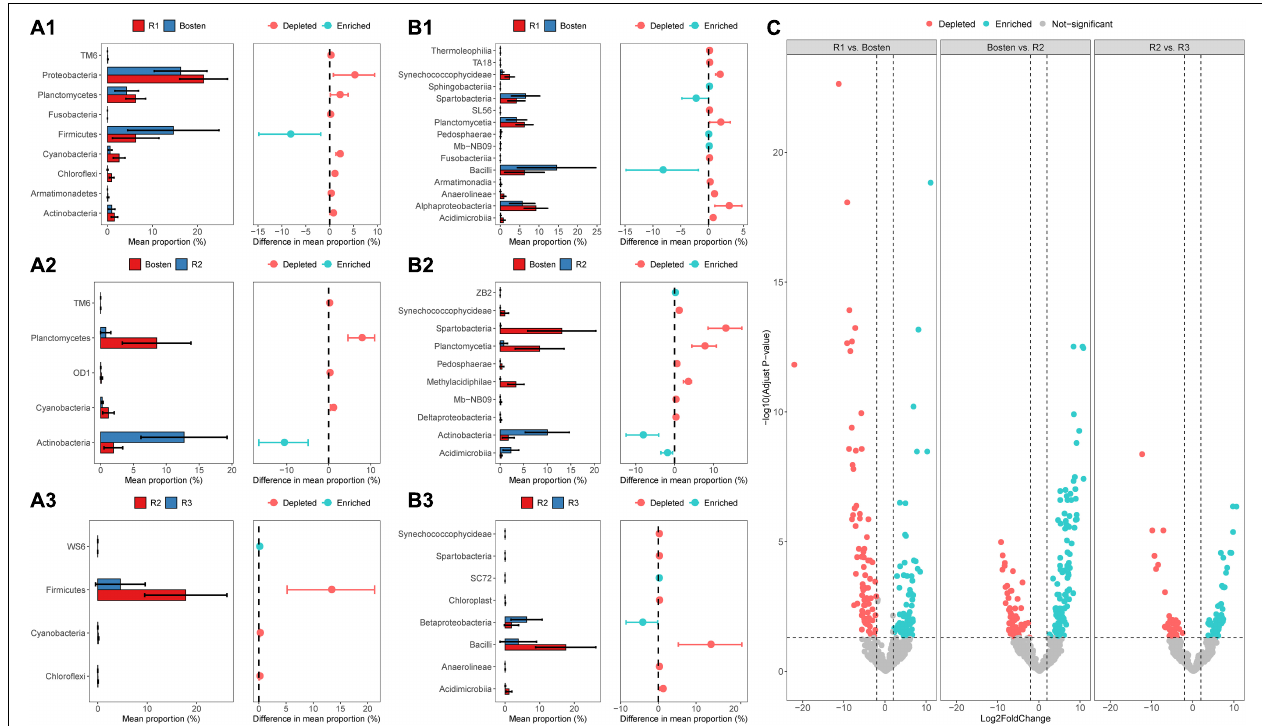
FIGURE 6 | The significantly changed bacterial groups from Lake R1 to Lake Bosten, R2, and R3 ( P < 0.05). (A1–A3) For the phylum level, (B1–B3) for the class level, (C) for the OTU